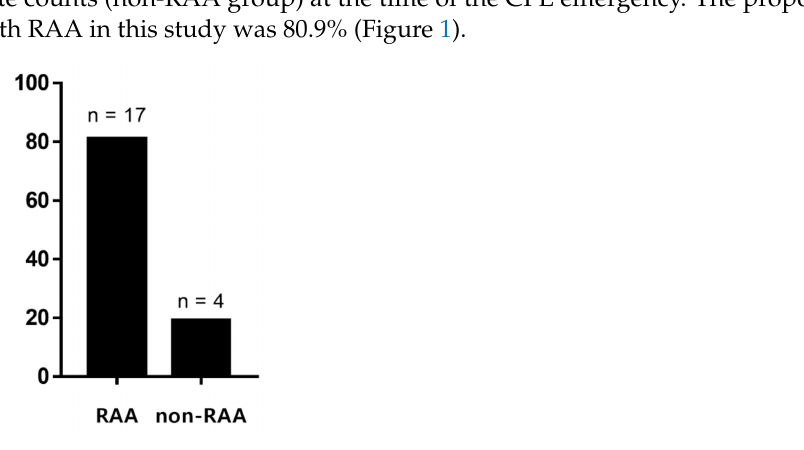
Figure 1. Proportion of reticulocytosis in the absence of anemia